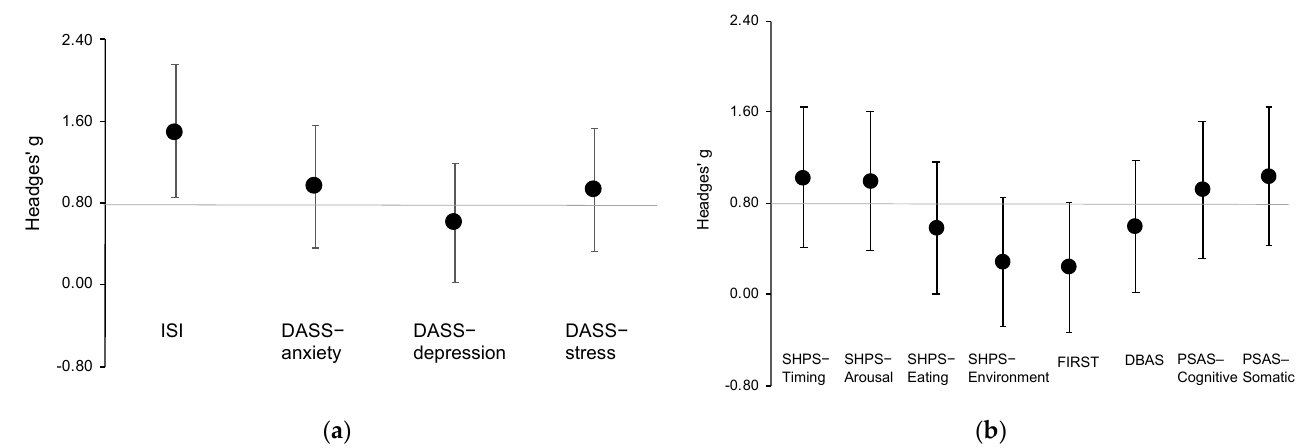
Figure 2. Plots of effect sizes through time for outcome measures between groups. ( a ) Effect sizes for main outcomes; ( b ) effect sizes for secondary outcomes. DASS, Depression Anxiety Stress Scale; DBAS, Dysfunctional Beliefs and Attitudes about Sleep; Error bars indicate 95% CI; FIRST, Ford Insomnia Response to Stress Test; ISI, Insomnia Severity Index; PSAS, Pre-Sleep Arousal Scale; SHPS, Sleep Hygiene Practice Scale. The horizontal line indicates a large effect size (g = 0.8). For stress, there was a significant effect of group (F 1,48 = 8.49, p = 0.001) and time (F 1,44 = 20.13, p < 0.001) but no significant group by time interaction (F 1,44 = 3.13, p = 0.084) for the